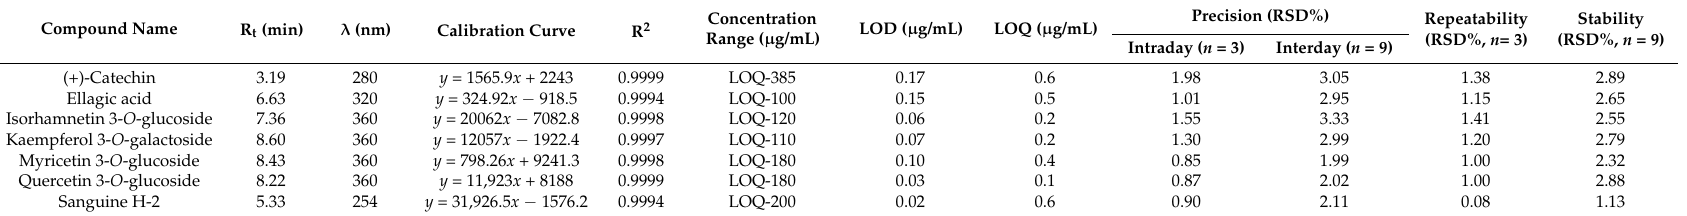
Table 4. Calibration data used for the UPLC-PDA quantification of phenolic compounds a